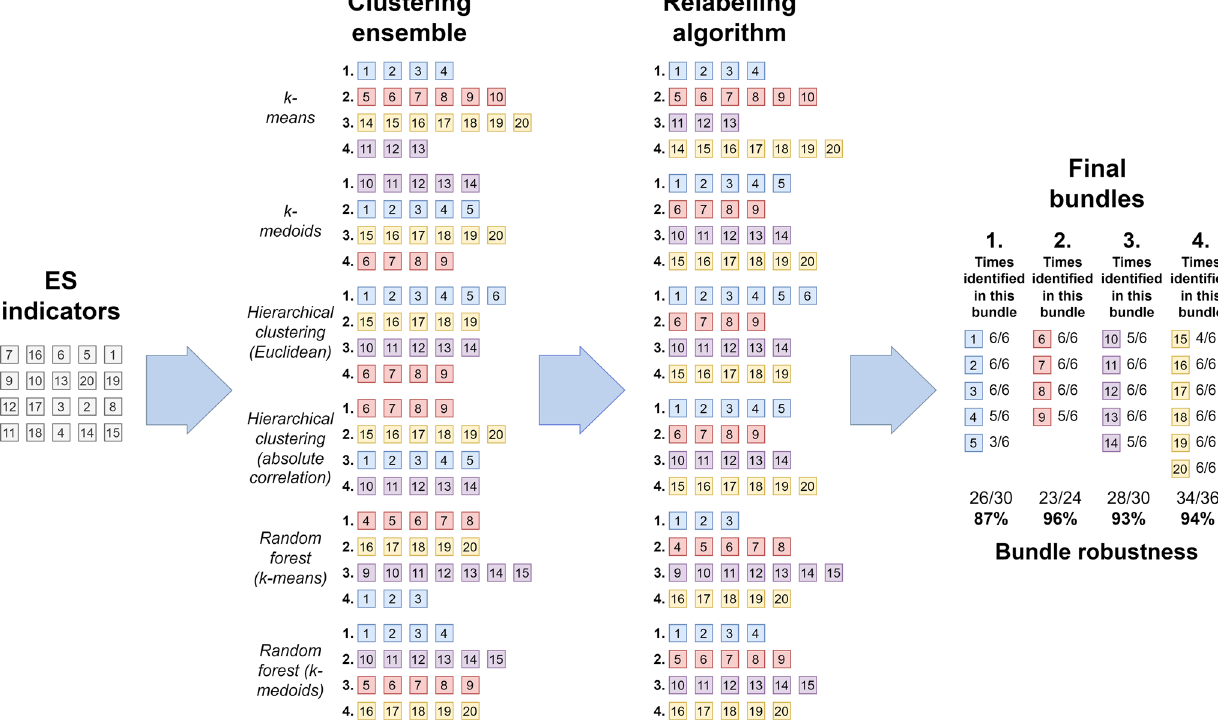
COMMUNICATIONS EARTH & ENVIRONMENT| (2022) 3:102